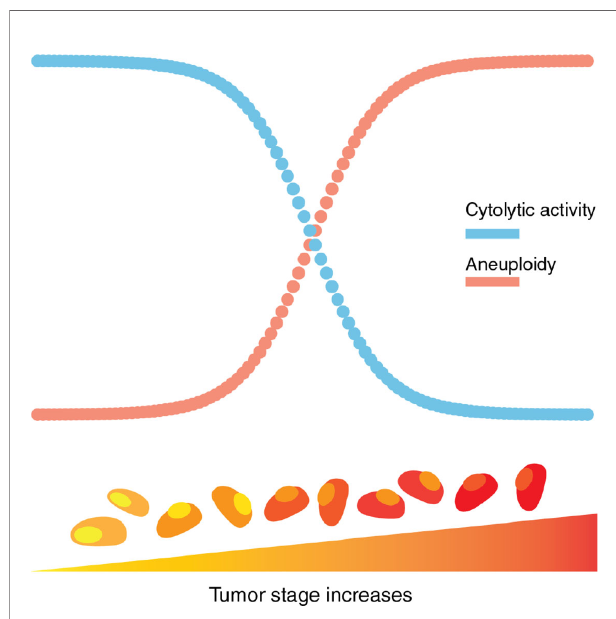
FIGURE 3 | Aneuploidy and cytolytic activity in tumor progression. Aneuploidy, as a measure of chromosomal abnormality, accumulates as tumor stage increases. In contrast, cytolytic activity, a representation of local immune-mediated cytotoxicity, decreases as tumor stage